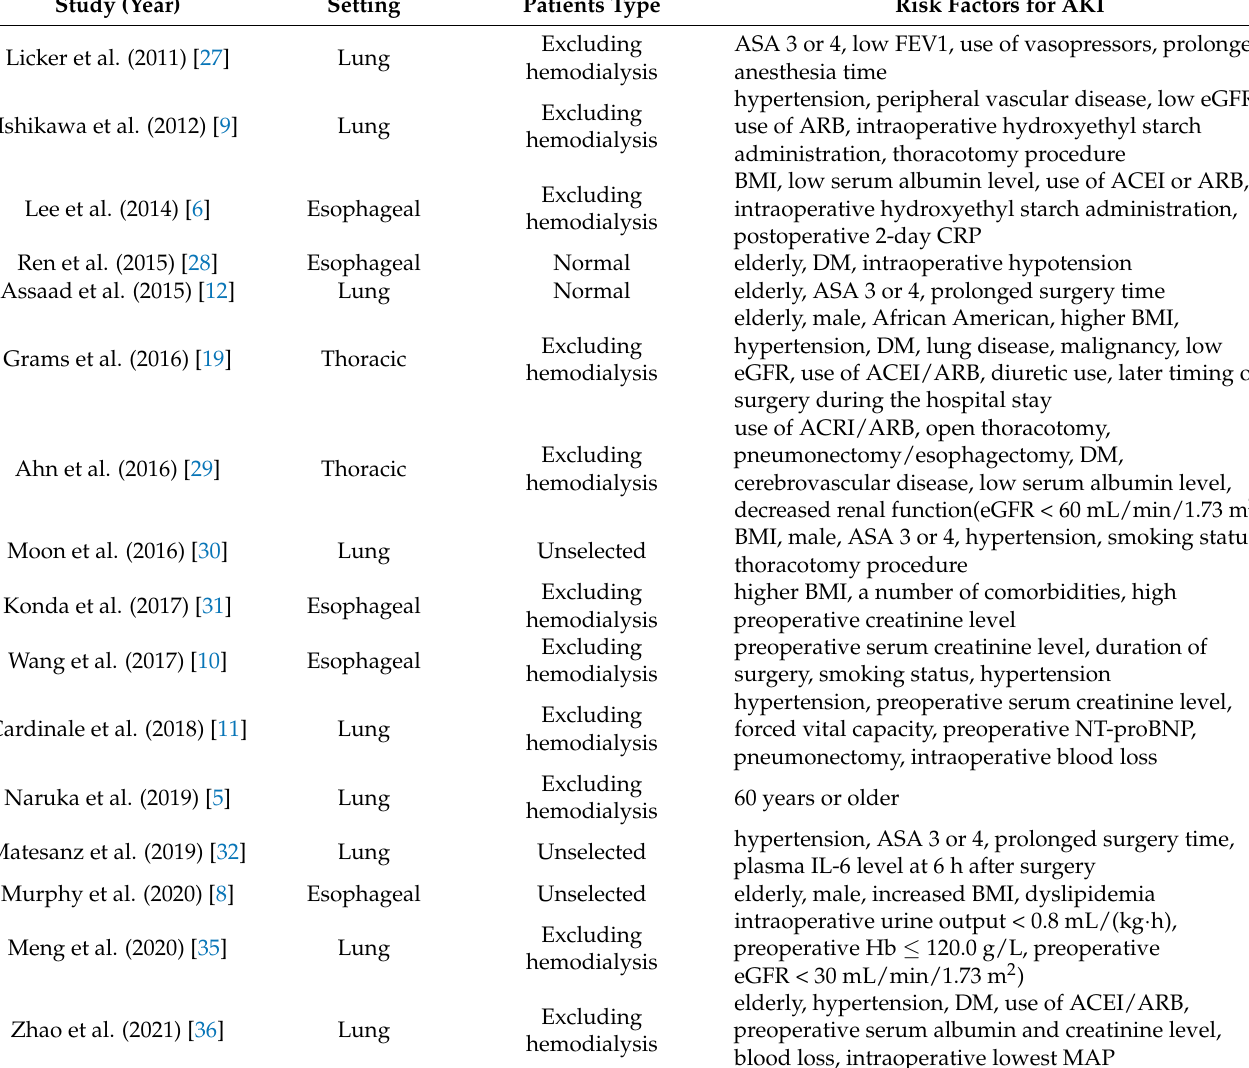
Table 3. Reported risk factors for AKI in patients undergoing thoracic surgery.